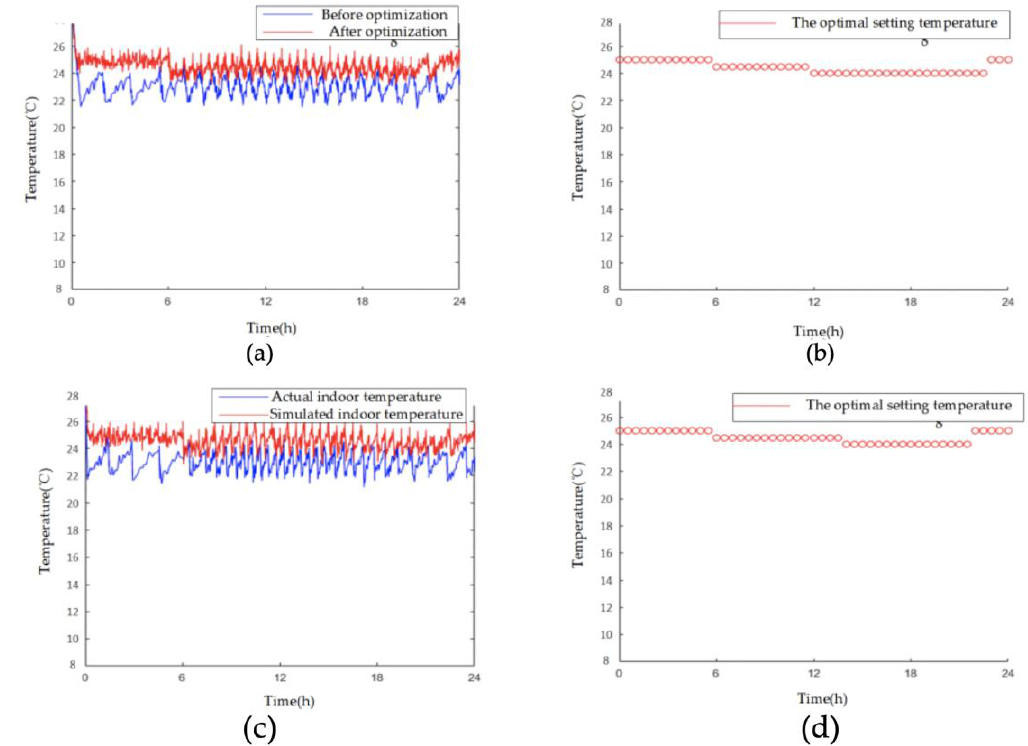
Figure 7. Energy saving optimization for air conditioning. ( a ) Indoor temperature of a certain office. ( b ) The optimal set temperature of the office. ( c ) Indoor temperature in a hyperbaric chamber. ( d ) The optimal set temperature of the hyperbaric chamber.